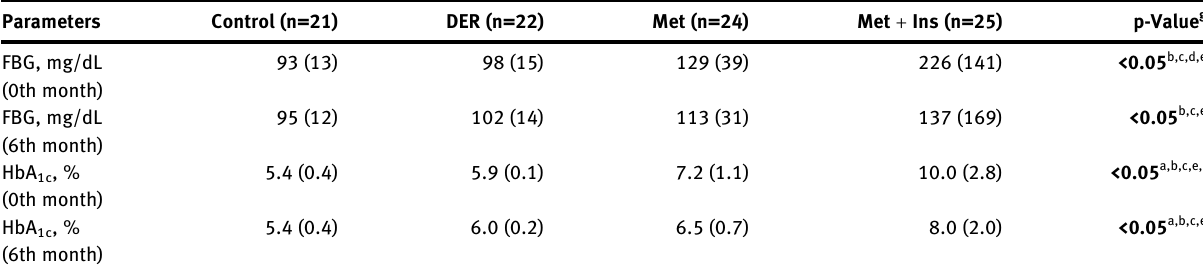
FBG,fastingbloodglucose;DER,dietandexerciserecommendedgroup;Met,metformingroup;Met + Ins,metformin + insulingroup. a p<  .  for